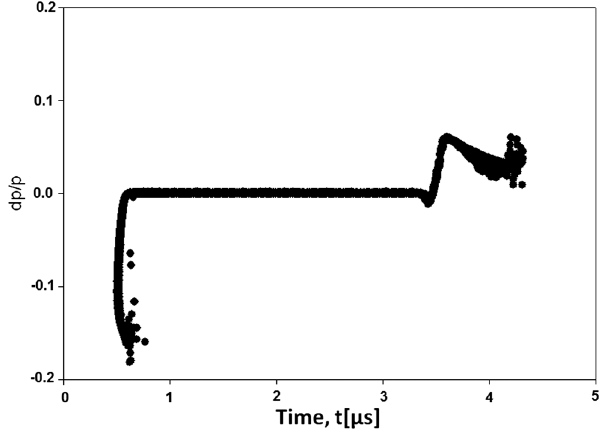
FIG. 26. Phase space distribution of particles at the end of the Einzel lens region.